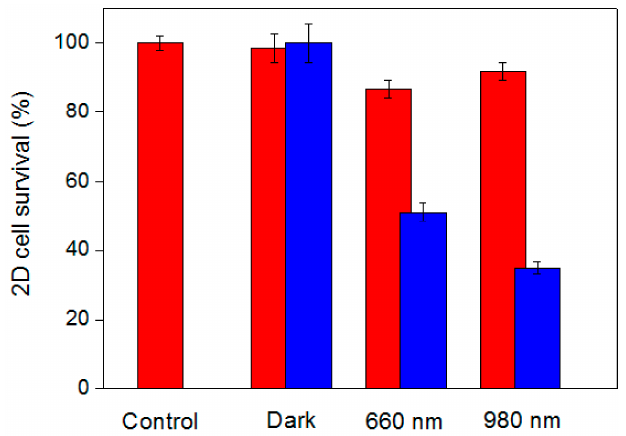
Figure 5. Photo-induced cytotoxicity for MCF-7 cells cultured in a 2D system in the presence of pristine Ce6 (red) and hybrid nanoparticles (blue) as the photosensitizer under laser irradiation. [Ce6] = 0.25 μ